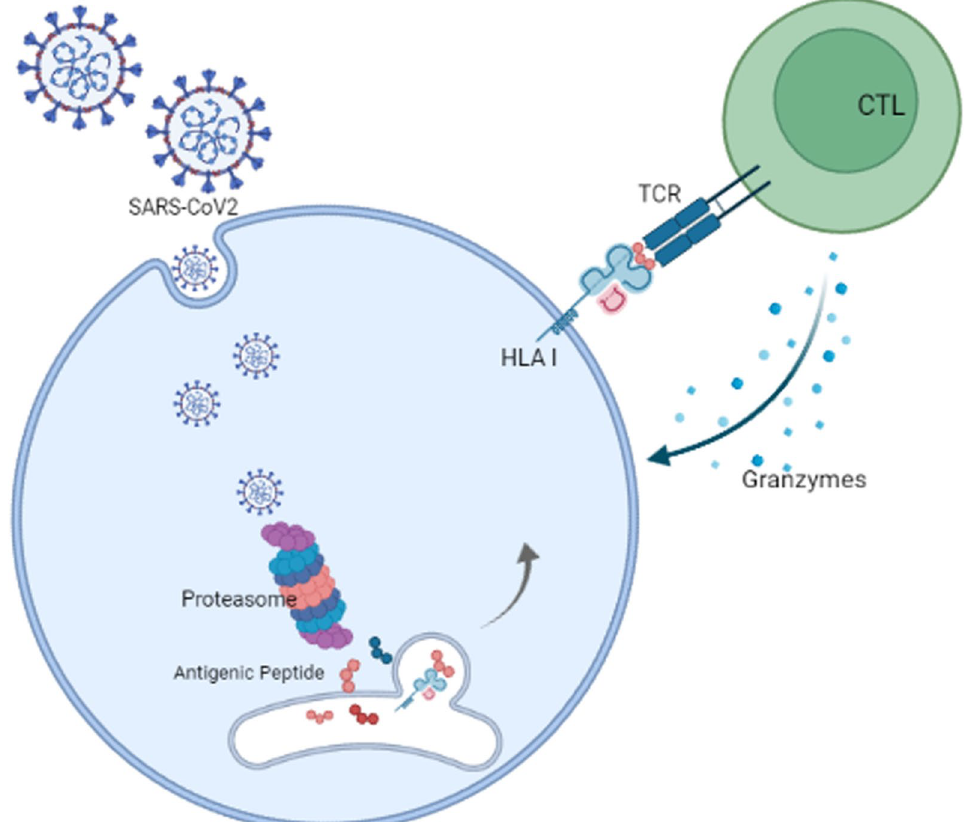
Fig. 1 SARS-CoV-2 antigen presentation pathway through MHC-I molecules. Cells infected with SARS-CoV-2 produce various isoforms of endoplasmic reticulum aminopeptidase 2 (ERAP2) genes dimerized with either ERAP2-wild type (wt) or ERAP1-wt which can be presented on cells and recognized by specific CD8 cytotoxic T lymphocytes (CTL). ER: endoplasmic reticulum; TAP: transporter associated with antigen processing + [36]. Created with